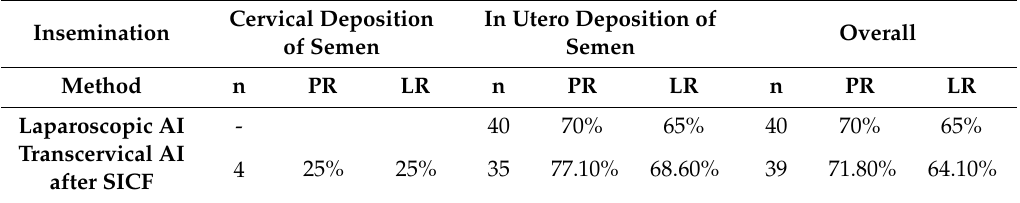
Table 1. Pregnancy (PR) and lambing rates (LR) in ewes submitted either to laparoscopic AI or transcervical AI after SICF (surgical incision of the cervical